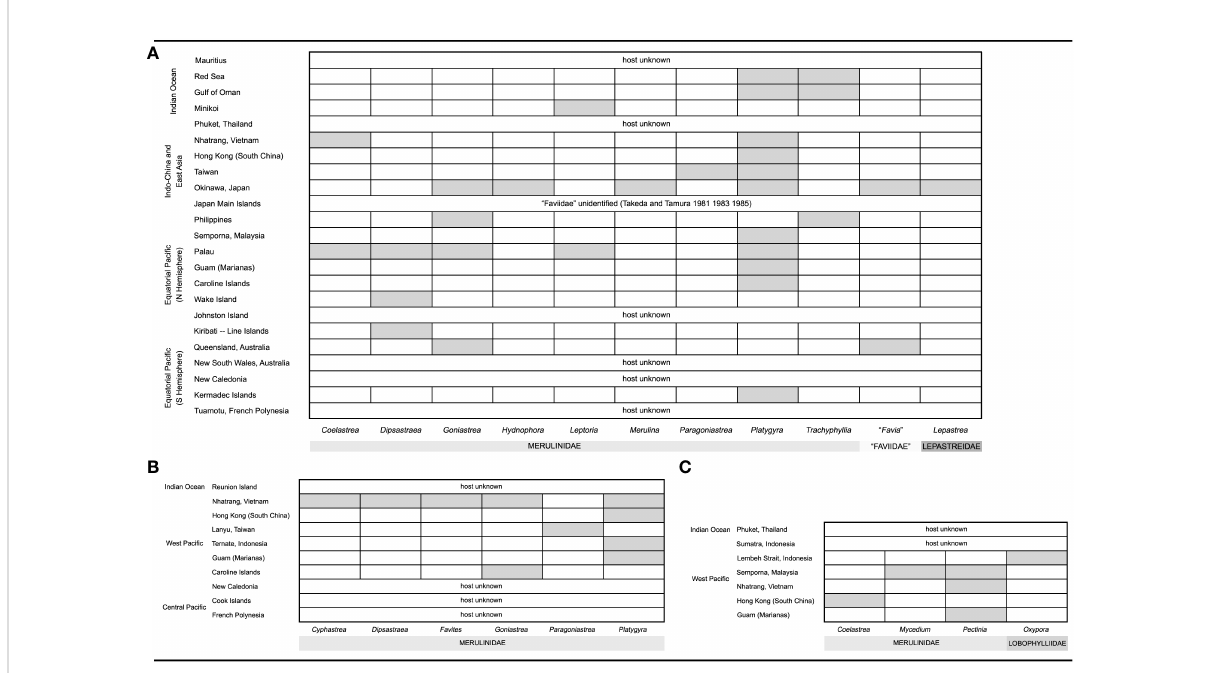
FIGURE 15 Host-distribution fi gures of three described species of cryptochirid crabs from the literature. The vertical column shows regions of occurrences, and the horizontal row shows hosts of genera reported. Tentative host identi fi cations as familial levels are omitted. (A) Cryptochirus coralliodytes (Sources: Heller, 1860 1861; Paul ’ son, 1875; Richters, 1880; Semper, 1881; Borradaile, 1902; Chilton, 1911; Potts, 1915; Edmondson, 1925; Edmondson, 1933; Hiro, 1937; Utinomi, 1944; Fize and Serène, 1957; McNeill, 1968; Takeda and Tamura, 1981a; Takeda and Tamura, 1983; Takeda and Tamura, 1985; Kropp, 1988a; Kropp, 1990; Poupin, 1996; Davie, 2002; Ng and Davie, 2002; Paulay et al., 2003; Poupin, 2005; Richer de Forges and Ng, 2006; Wei et al., 2006; Castro, 2011; van der Meij and Nieman, 2016). (B) Lithoscaptus paradoxus (Sources: (A) Milne- Edwards, 1862; Fize and Serène, 1957; Kropp, 1988a; Kropp, 1990; Paulay et al., 2003; Poupin, 2005; Richer de Forges and Ng, 2006; Wei et al., 2006; van der Meij and Nieman, 2016). (C) Xynomaia sheni : so far, four distinct COI haplotypes have been recognized, the genetic distance among which suggesting inter-speci fi c divergence (see main text). Three of these haplotypes were found among our six specimens from Hong Kong. Which of these haplotypes represent the “ real ” X. sheni remains unknown. (Sources: Fize and Serène, 1957; Takeda and Tamura, 1981b; Kropp, 1990; Ng and Davie, 2002; Paulay et al., 2003; van der Meij and Reijnen, 2014; van der Meij and Nieman,